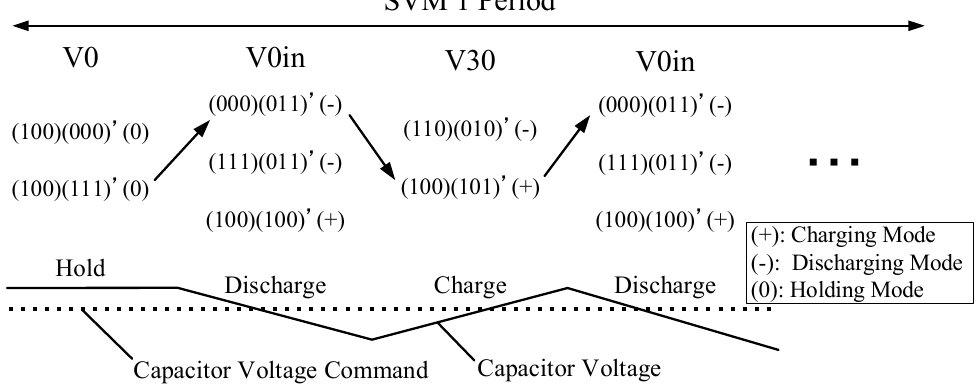
Figure 5. Redundant switching states and capacitor charging and discharging operation.